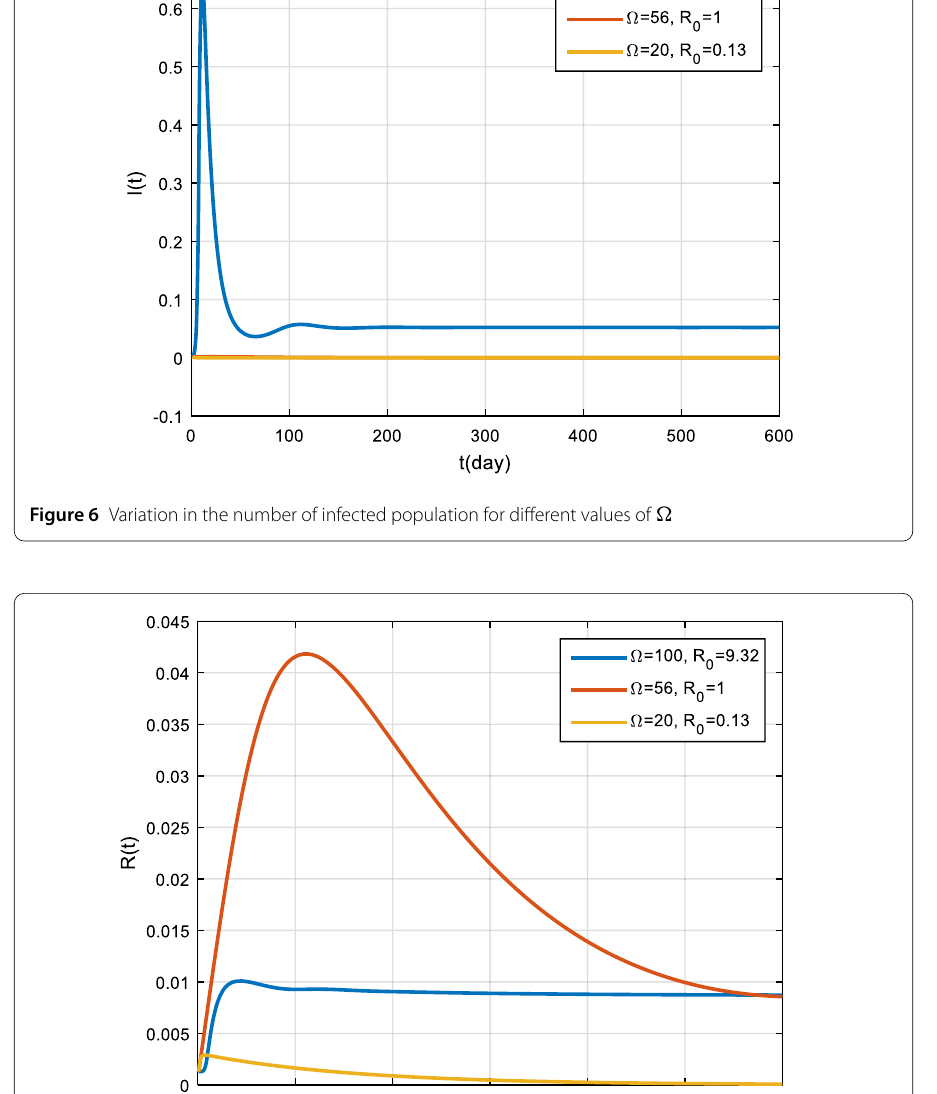
in Table 2 and Table 3. The values of (cid:7) 0 , (cid:7) min , and (cid:7) should be determined by a virolo- gist, while the value of parameter ϑ should be determined by a physician. For each of the controlled parameters, namely the parameters of vaccine effectiveness, level of obedience in implementing health protocols, treatment effectiveness, and corona virus-load, simu- lations are carried out three times for each parameter with different values, as in Table